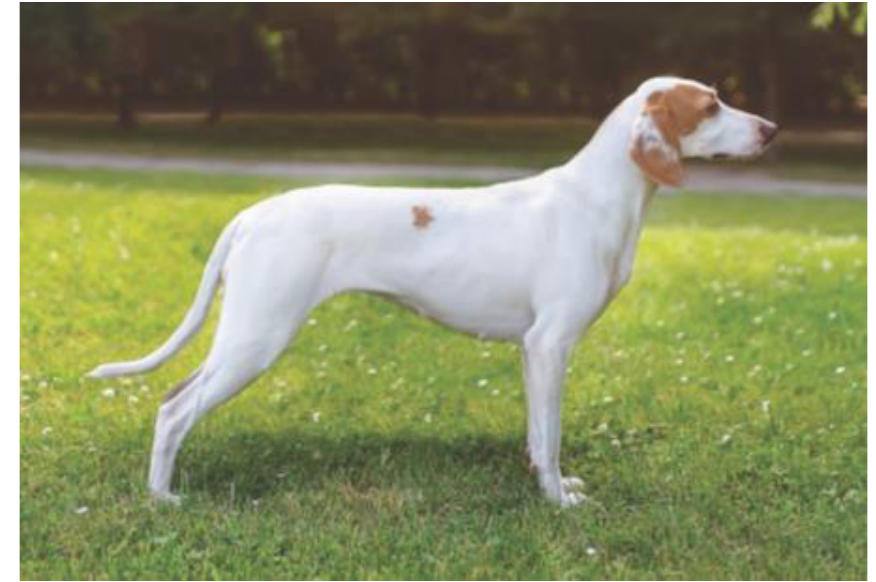
Figure 2. Istrian shorthaired hound [2] .